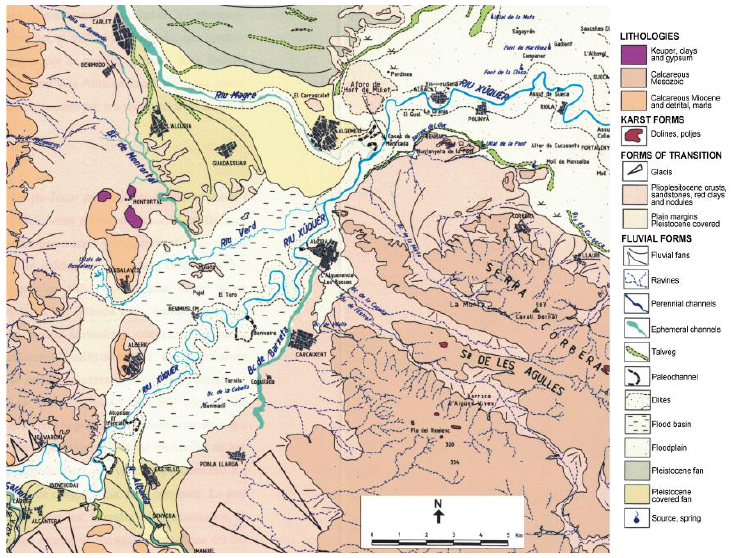
Figure 7. Cut out of the geomorphological map of the Ribera Alta. Source: Ruíz Pérez [54].